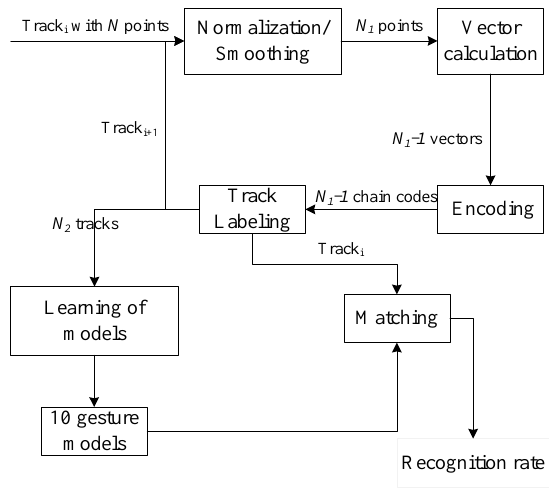
Figure 4. Workflow of gesture recognition